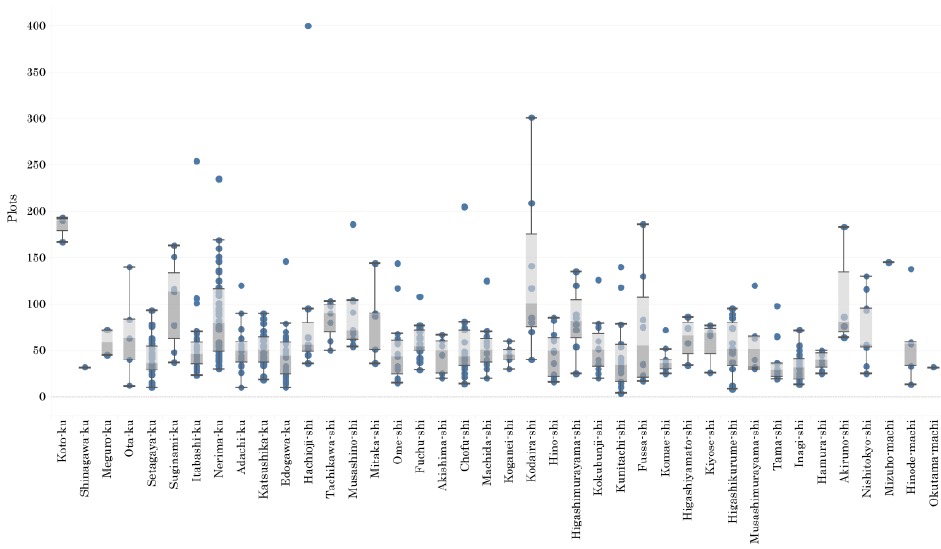
Figure 6. Box-and-whisker plot for the number of AGs plots, was created by Tableau 2020.4.